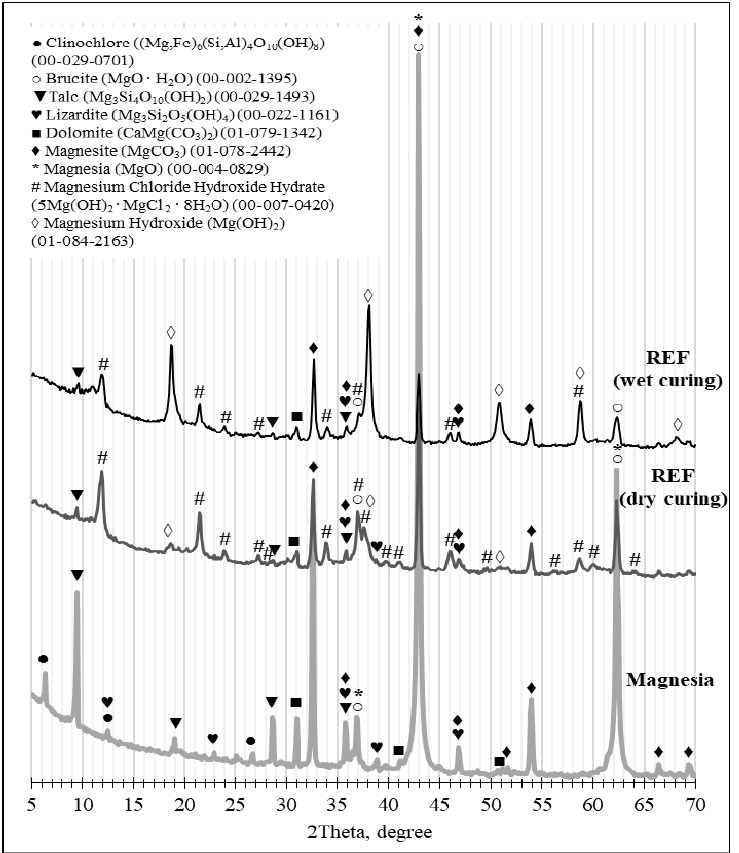
Figure 5. X-ray diffractograms of raw Magnesia and REF sample on Day 28 after wet and dry curing.